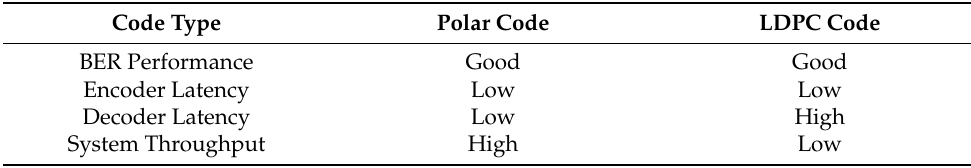
Table 5. Qualitative simulation results